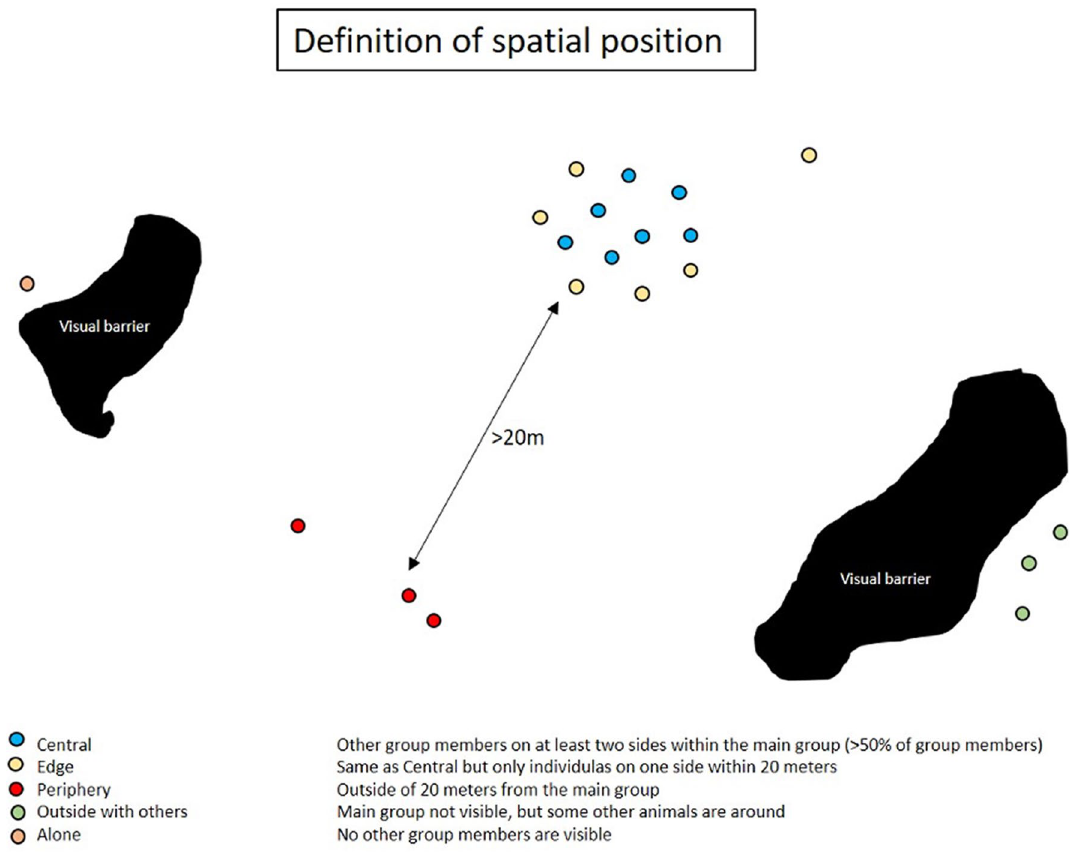
Figure 1. Definitions and estimation of macaques’ spatial position with respect to their group. Figure was created using Microsoft PowerPoint (Version